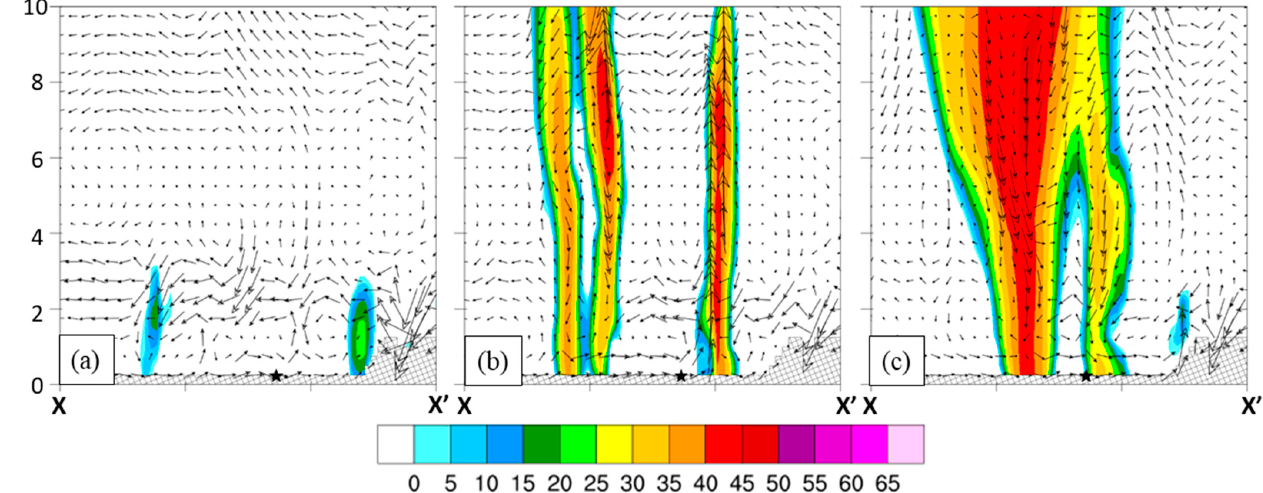
Figure 13. Vertical cross section of maximum reflectivity and horizontal wind vector of CDA03 simulations at ( a ) 0600, ( b ) 0700, and ( c ) 0800 UTC (from 1400 to 1600 LST) on 5 August 2018, along the northwest-to-southeast plane (from x to x’) depicted in Figure 10. The title of each chart showed the accurate location of reflectivity we selected and the approximate location of Pingtung Air Force Base was depicted as black star.